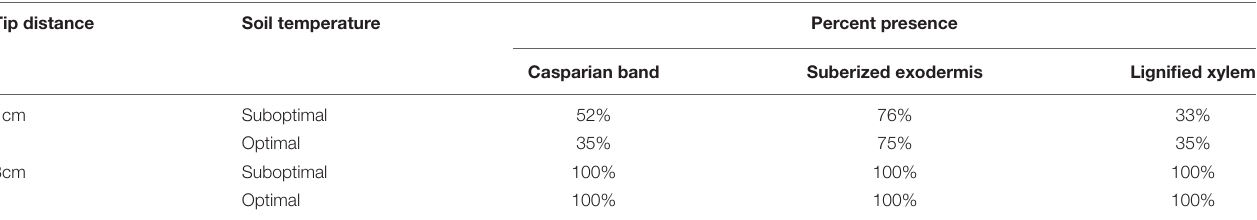
TABLE 2 | Presence of Casparian band, suberized exodermis, and lignified xylem in roots exposed to optimal and suboptimal soil temperatures for 4 weeks and sectioned at 1 and 3 cm from the apex.